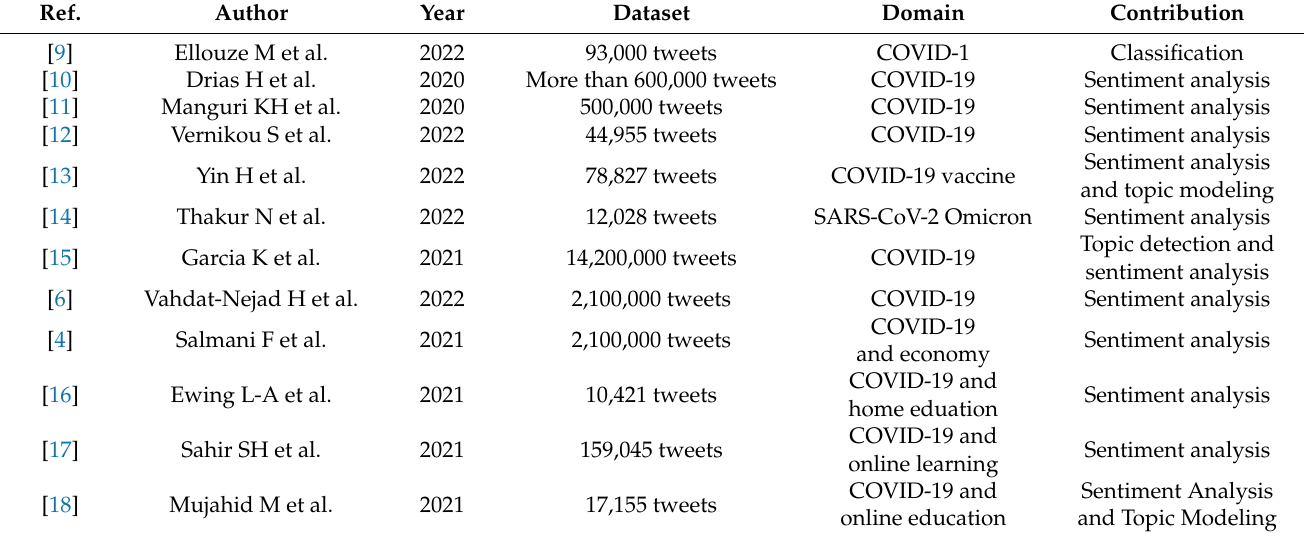
Table 1. A summary of the discussed research